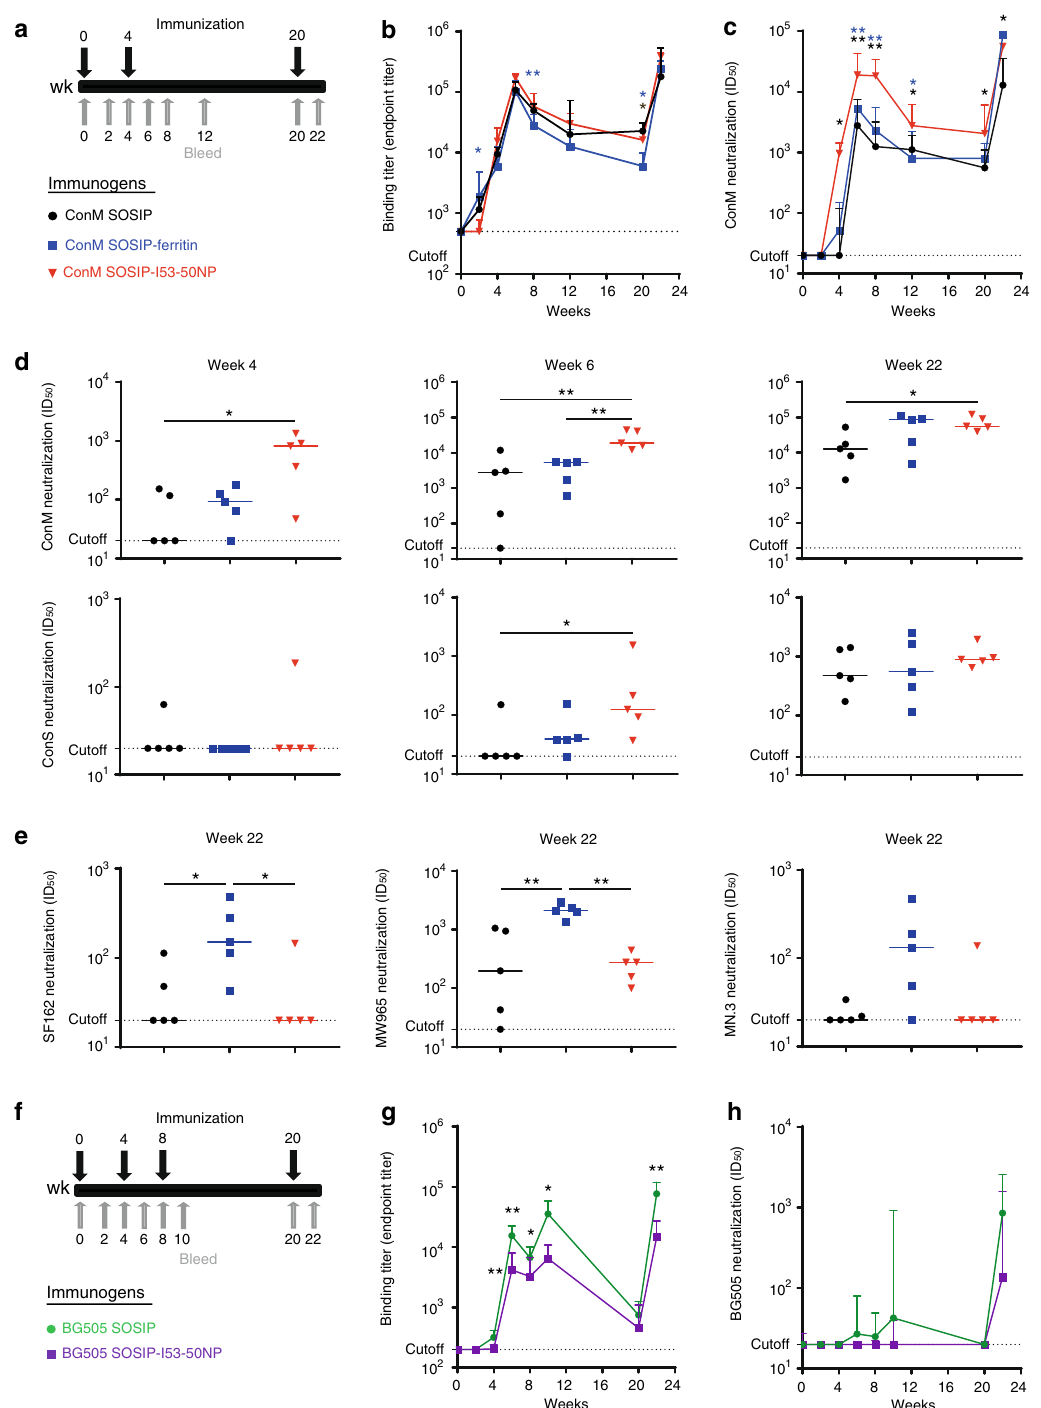
Fig. 5 Immunogenicity of ConM and BG505 SOSIP-I53-50NPs. a , f Schematic representation of the immunization schedule and color coding for the immunogens tested. b – e , g , h Statistical differences between two groups ( n = 5 individual rabbits for ( b – e ); n = 8 individual rabbits for ( g , h )) were determined using unpaired two-tailed Mann – Whitney U -tests (* p <0.05; ** p <0.01). b . ConM SOSIP endpoint binding titers over time as measured by Ni-NTA enzyme- linked immunosorbent assay (ELISA). Blue stars indicate signi fi cant differences for ConM SOSIP-ferritin vs. ConM SOSIP-I53-50NP. Brown stars indicate signi fi cant differences for ConM SOSIP vs. ConM SOSIP-ferritin. Shown are medians with interquartile range. c ConM midpoint neutralization titers over time. Blue and black stars indicate signi fi cant differences for ConM SOSIP-ferritin vs. ConM SOSIP-I53-50NP and ConM SOSIP vs. ConM SOSIP-I53-50NP, respectively. Shown are medians with interquartile range. d ConM and ConS midpoint neutralization titers at week 4 (left), week 6 (middle), and week 22 (right). Horizontal bars indicate the median. For replicate neutralization data from Duke UMC, see also Supplementary Table 2. e SF162, MW965, and MN.3 midpoint neutralization titers at week 22. Horizontal bars indicate the median. See also Supplementary Table 2. g BG505 SOSIP endpoint binding titers over time as measured by Ni-NTA ELISA. Shown are medians with interquartile range. h BG505 midpoint neutralization titers over time. Shown are medians with interquartile range. See also Supplementary Table 3. Source data are provided as a Source Data fi le 10 NATURE COMMUNICATIONS| (2019) 10:4272